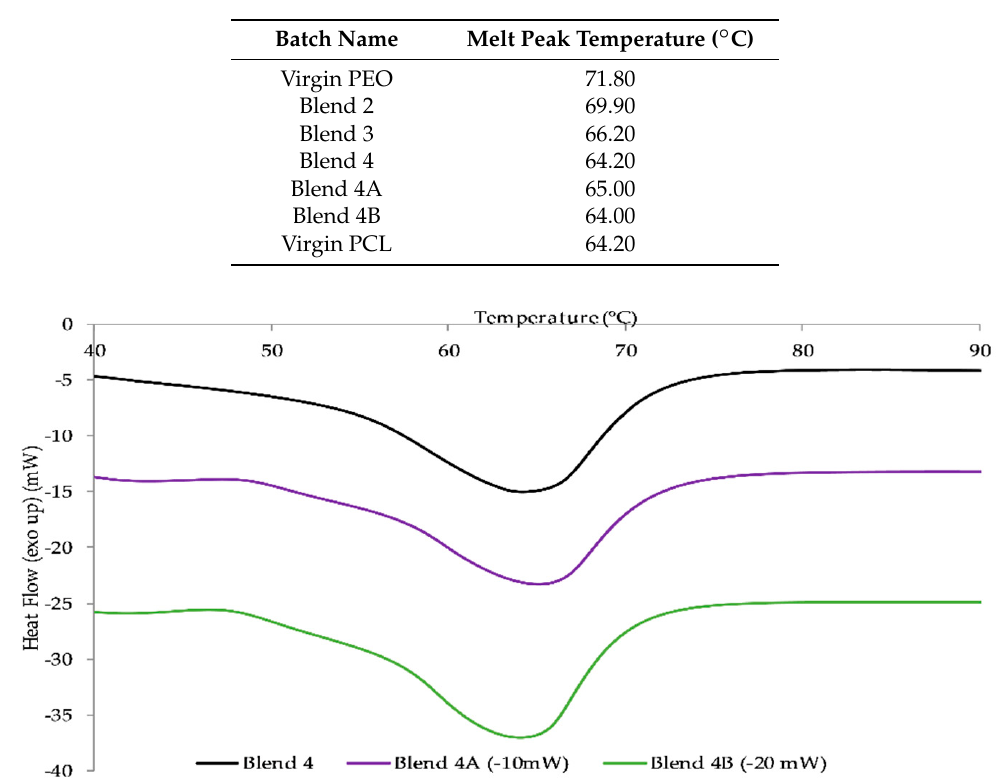
Table 6. Differential scanning calorimetry (DSC) results of monolithic and nanocomposite batches.